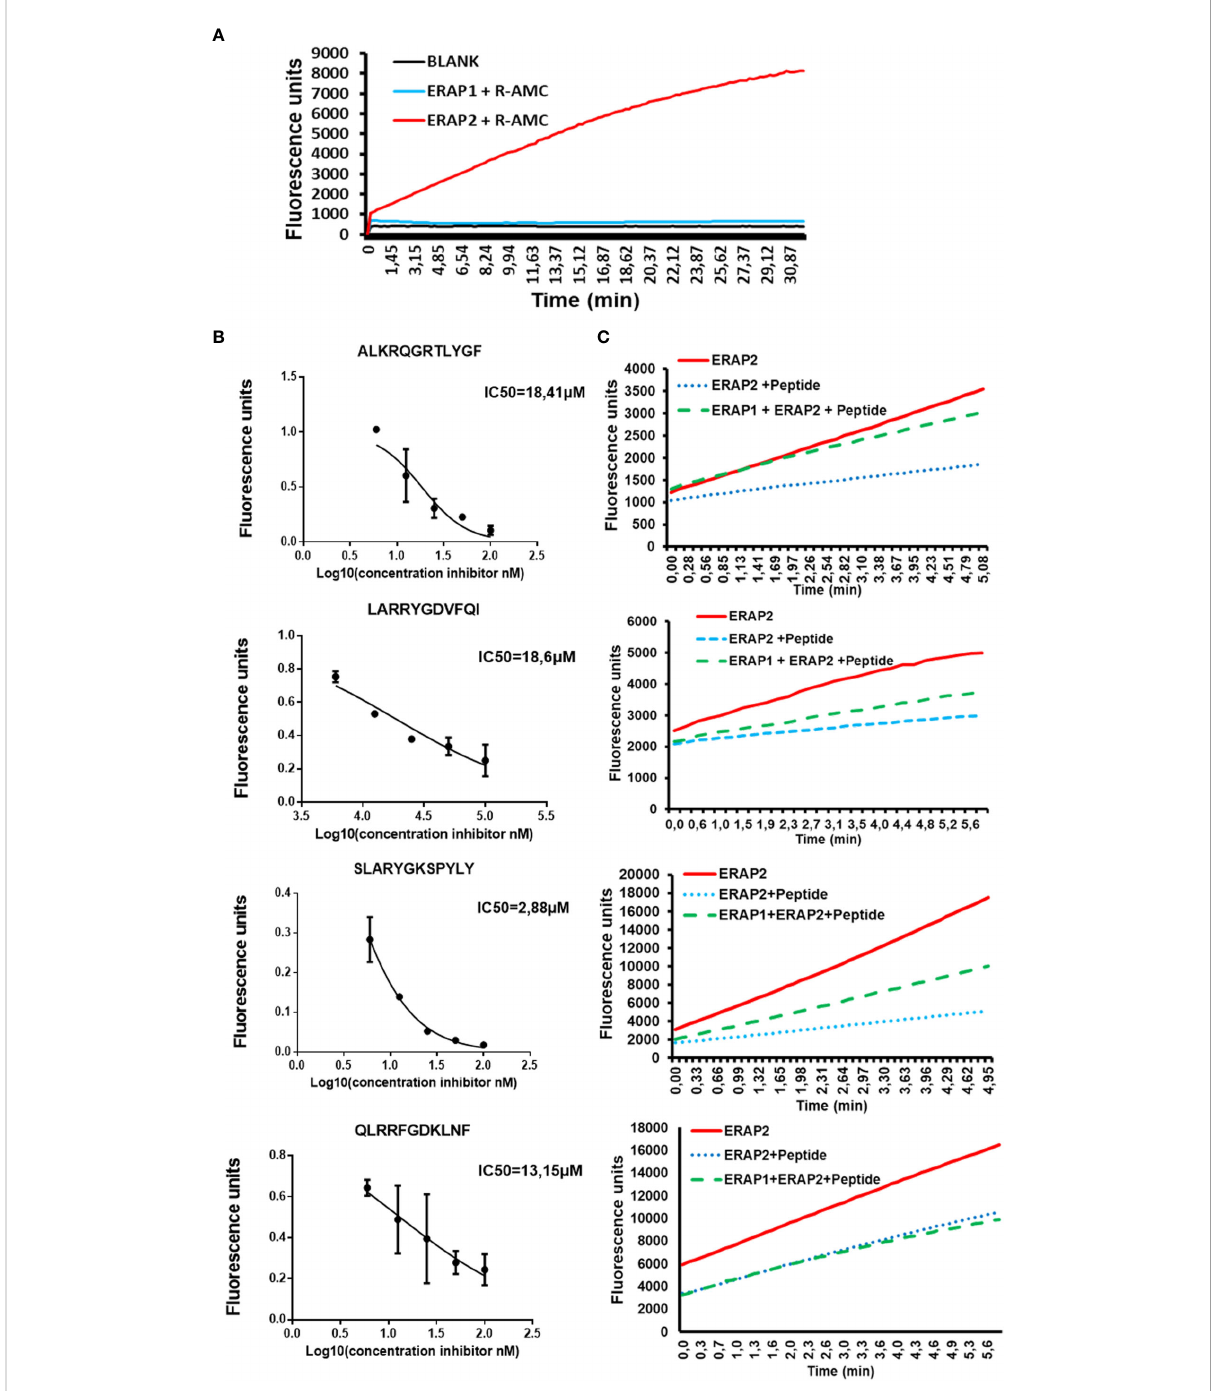
FIGURE 3 ERAP1 activity can rescue inhibition of ERAP2 R-AMC hydrolysis by long peptides (A) ; R-AMC hydrolysis time course [E:S, 1:30) (w/w), ERAP2 alone (Black), ERAP2 and R-AMC (Red), ERAP1 with R-AMC (Blue). AMC fl uorescence was measured as a function of time. (B) ] Increasing Long peptide concentrations were incubated with ERAP2 and R-AMC, IC50 for each peptide was calculated. (C) ; ERAP2 was incubated with R-AMC in the absence of peptide (Solid Red), or the IC50 for each long peptide (Dotted Blue). Long peptides were pre-incubated with ERAP1 for 32min, products were puri fi ed and added to a reaction containing ERAP2 and R-AMC (Dashed Green). The data are the mean of 3